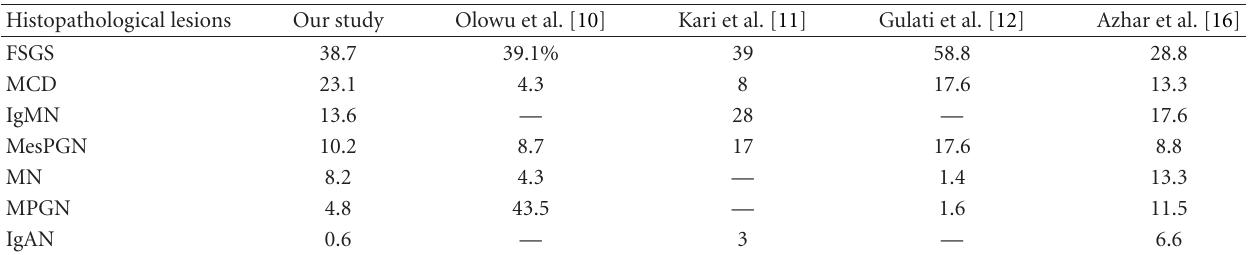
FSGS:focalsegmentalglomerulosclerosis;IgANL:IgAnephropathy;IgMN:IgMnephropathy;MCD:minimalchangedisease;MesPGN:mesangioproliferative GN; MN: membranous GN; MPGN: mesangiocapillary or membranoproliferative